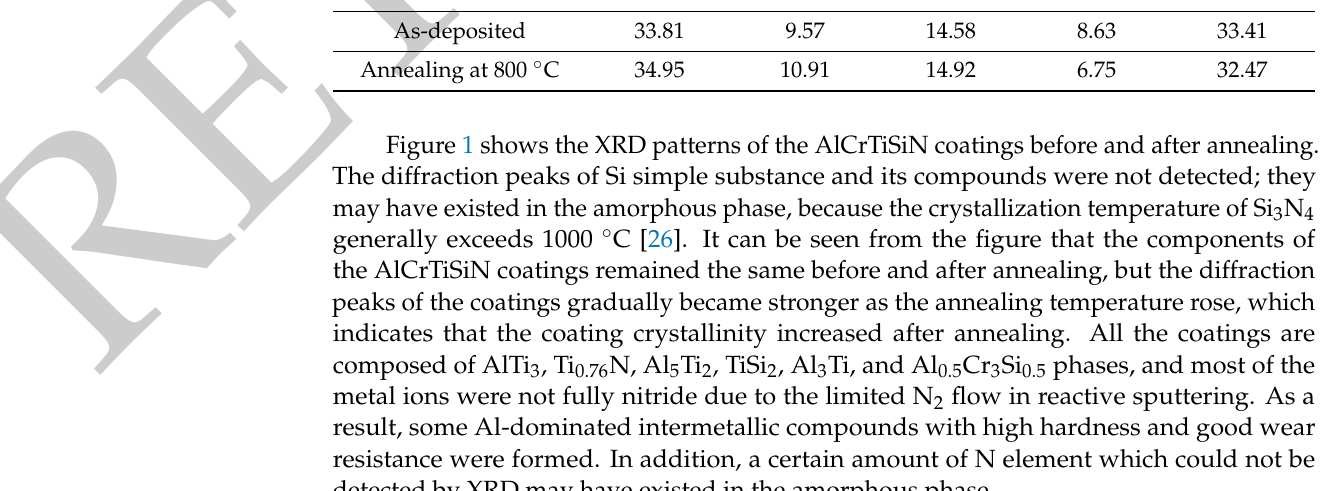
Table 3. Composition of the AlCrTiSiN coatings before and after annealing (at.%). Status Al